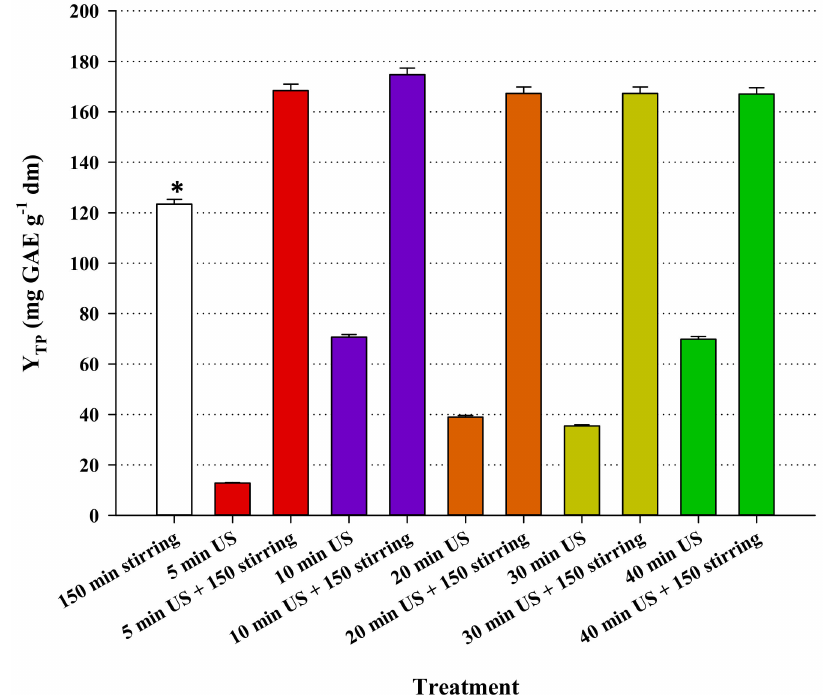
Figure 5. Bar diagram presenting the e ff ect of ultrasonication pretreatment on the total polyphenol extraction yield from elderberry flowers (EBF), using stirred-tank extraction under optimal conditions, at 80 ◦ C. Ultrasonication prior to stirred-tank extractions was performed at ambient temperature (22 ± 1 ◦ C). Asterisk (*) indicates statistically di ff erent value ( p < 0.05).